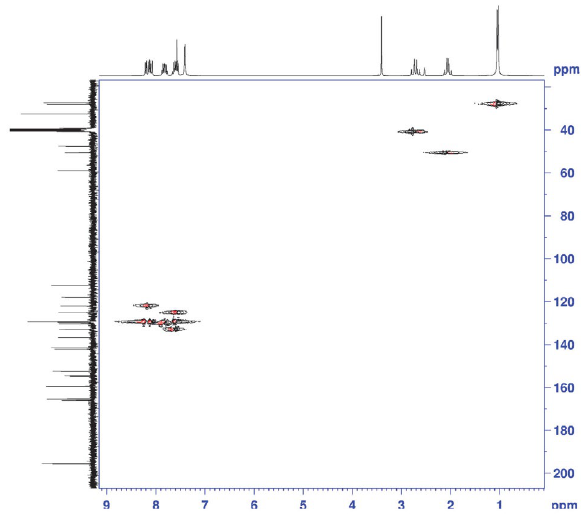
Fig. 1. HSQC spectrum of